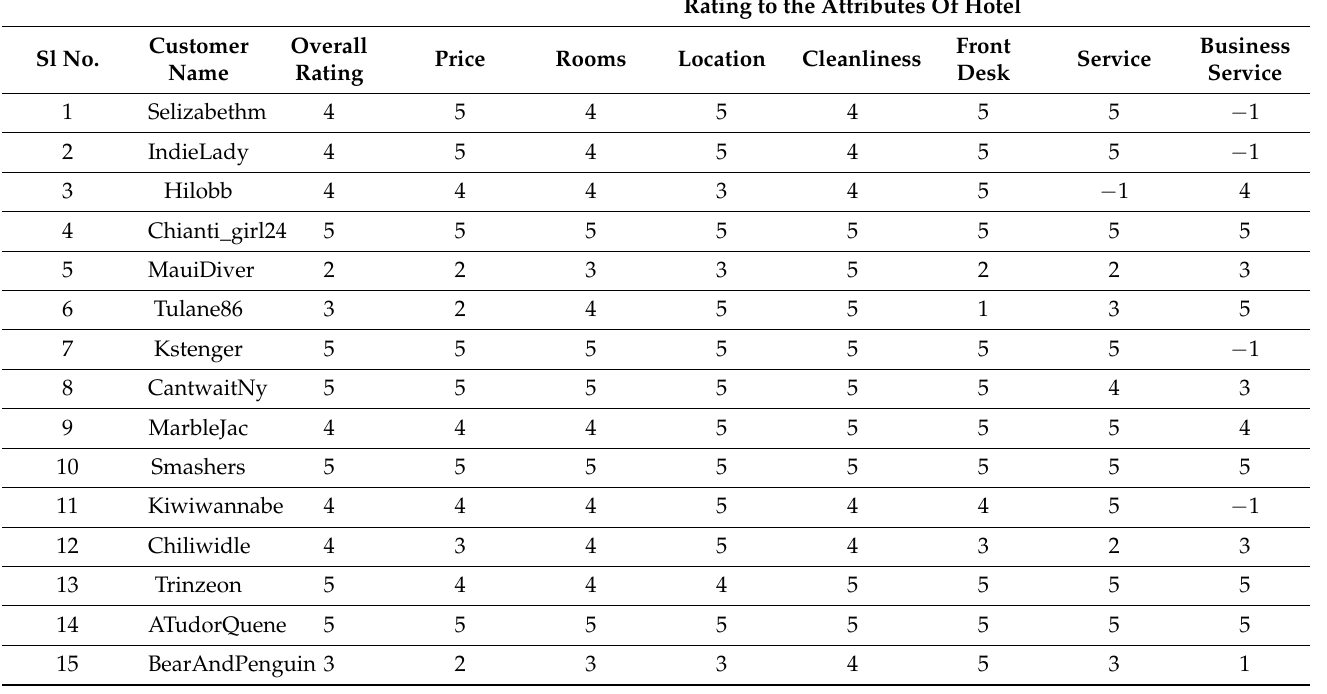
Table 2. Sample Customer Ratings to Monaco Seattle Hotel. Rating to the Attributes Of